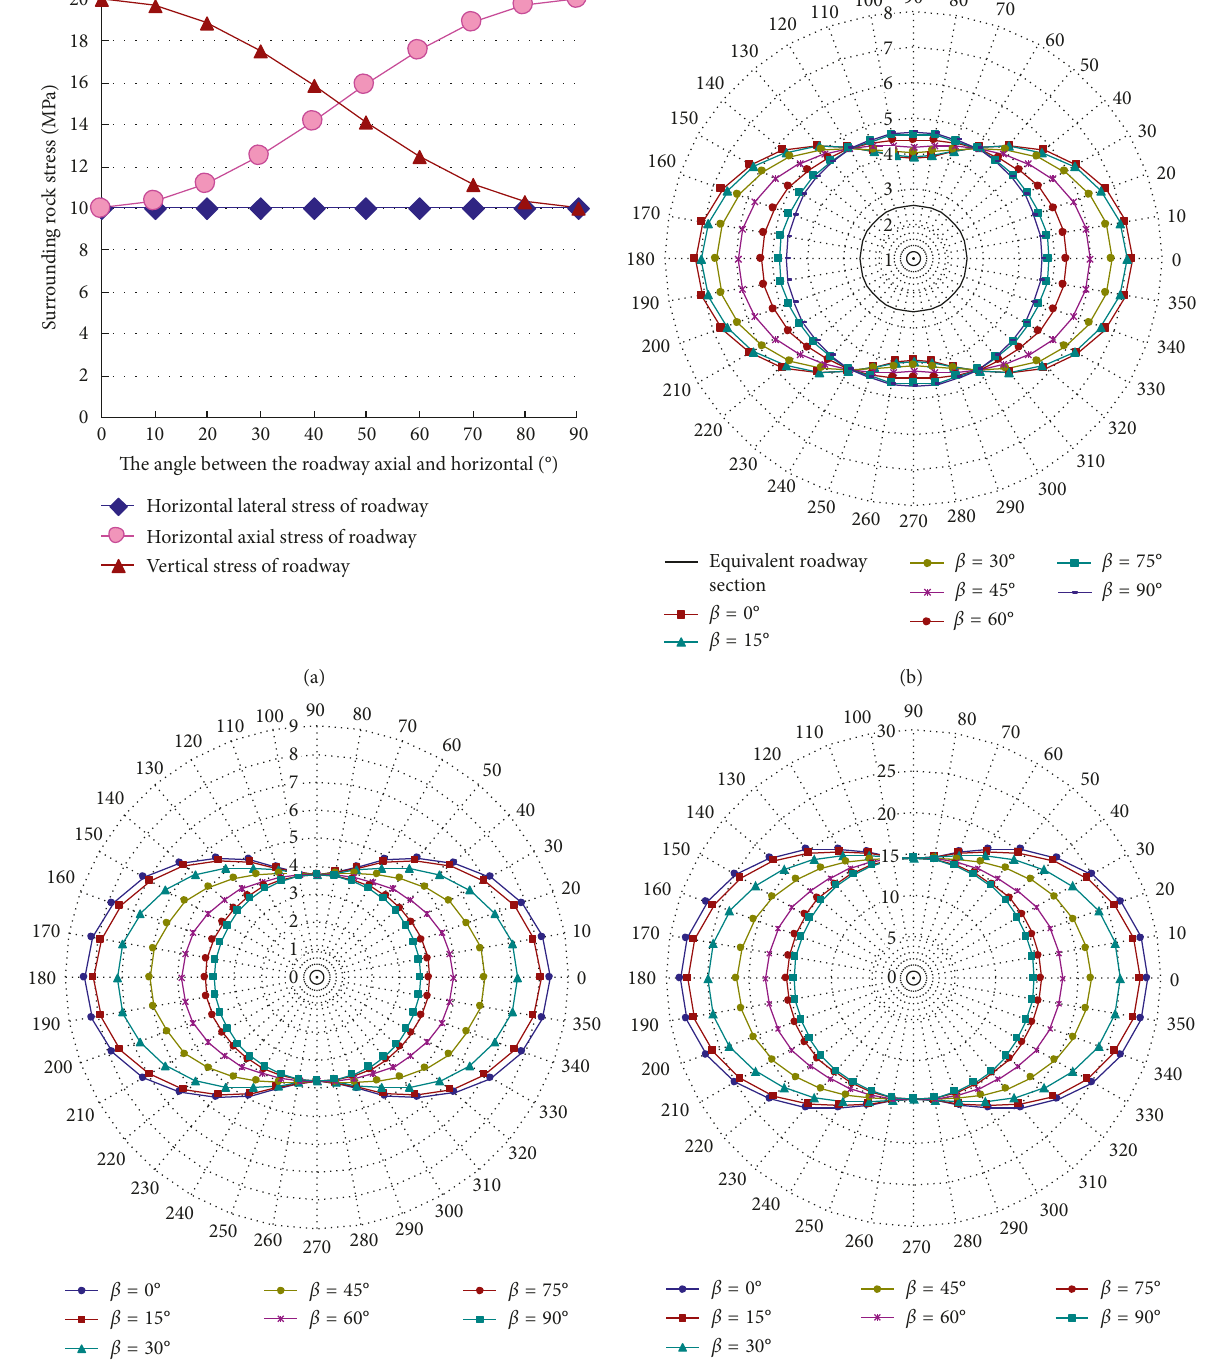
Figure 4: The three-directional stress states and change rules of the stress distribution in the surrounding rock plastic zone and plastic zone boundary with the increase of β . (a) Three-dimensional stress state change, (b) plastic failure zone distribution changes, (c) plastic failure zone boundary radial stress distribution change, and (d) plastic failure zone boundary tangential stress distribution